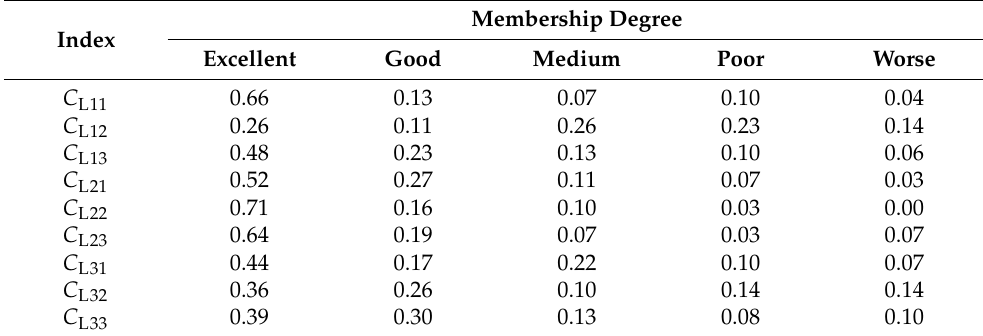
Table 1. Membership degree of each index relative to evaluation scale set V